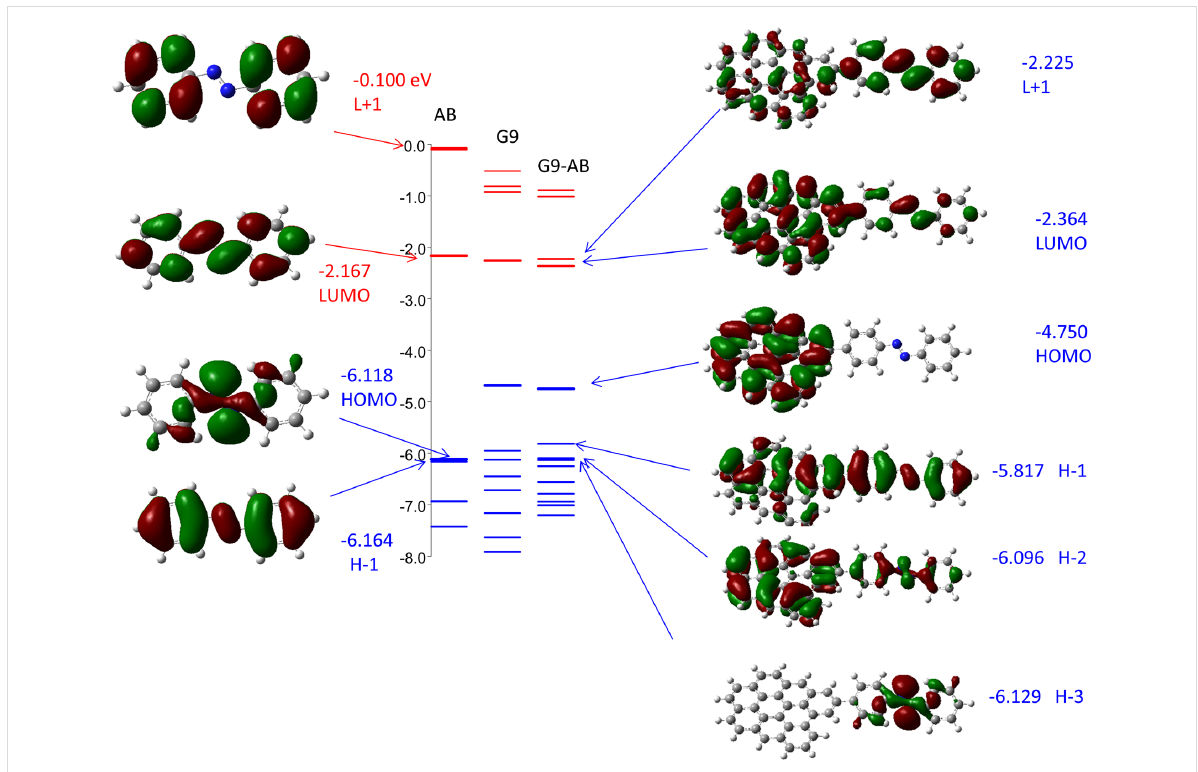
Figure 2: Energy level diagram comparing orbital energies for isolated AB and G9, compared to the G9–AB cluster (middle), all in eV relative to a vacuum reference. Selected orbitals and their energies (in eV) are surround the diagram. Molecules are in their optimized geometries, with a 37° dihe- dral between G9 and AB planes in